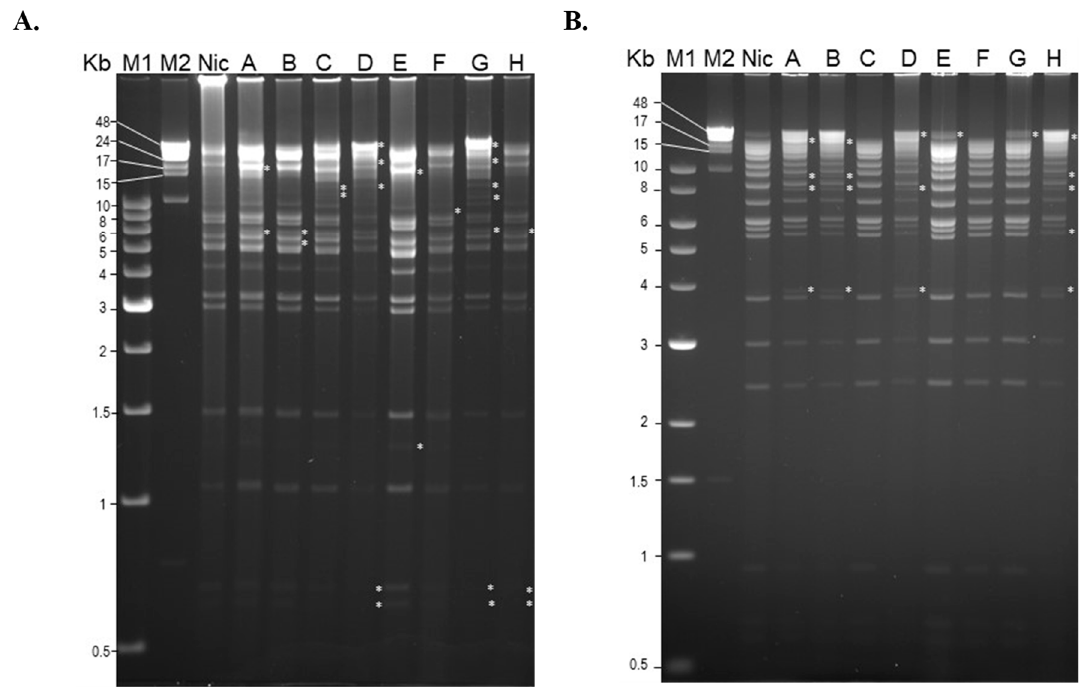
Figure 2. Restriction endonuclease analysis of a selection of soil-derived isolates of SfMNPV (lanes A-H) compared to the SfMNPV-NIC reference isolate (Nic). Genomic DNA was digested with ( A ) PstI or ( B ) HindIII and subjected to electrophoresis in 0.6% and 0.8% agarose, respectively. The isolates used for this analysis were SfMNPV-NIC (labeled Nic) sample #121 (labeled A), #36 (B), #37 (C), #19 (D), #152 (E), #92 (F), #177 (G), and #50 (H), following the sample numbers given in Supplemental File S1. Restriction fragments and sub-molar bands that differed from those of SfMNPV-NIC are labeled with an asterisk. Molecular markers were NEB 1 Kb ladder (M1) and NEB λ mono-cut DNA